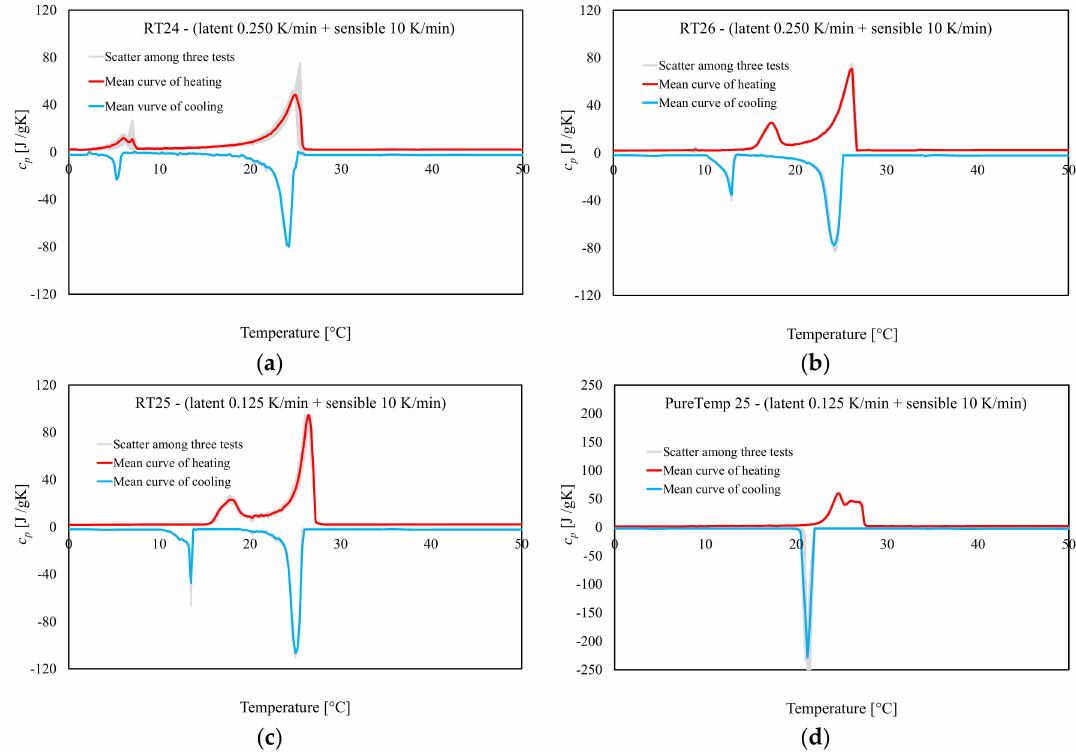
Figure 11. Specific heat capacities following the dynamic DSC tests (for heating between 0 ◦ C and 50 ◦ C and cooling between 50 ◦ C and 0 ◦ C): ( a ) RT24, ( b ) RT26, ( c ) RT25 and ( d ) PureTemp 25. Note: the total specific heat capacities have been constructed by additively linking the sensible parts with the latent